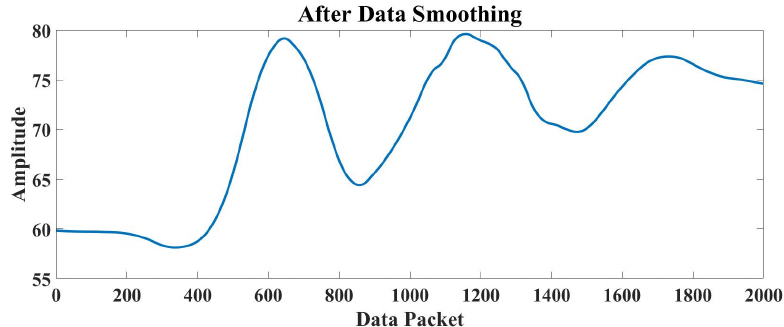
Figure 8. After smoothing treatment.